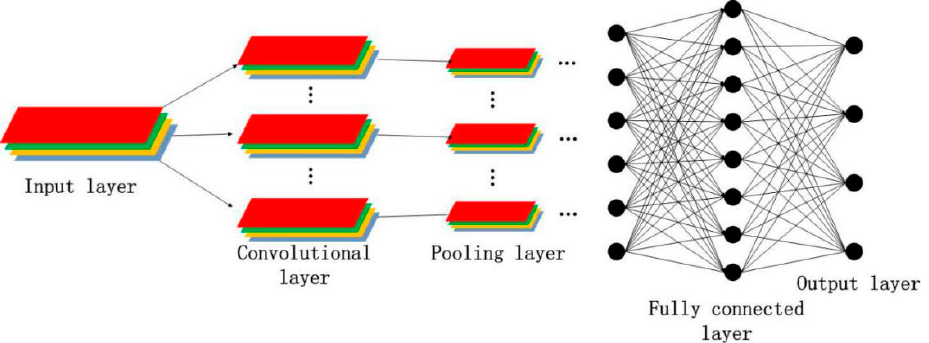
Figure 1. Typical model structure of a convolutional neural network (CNN).